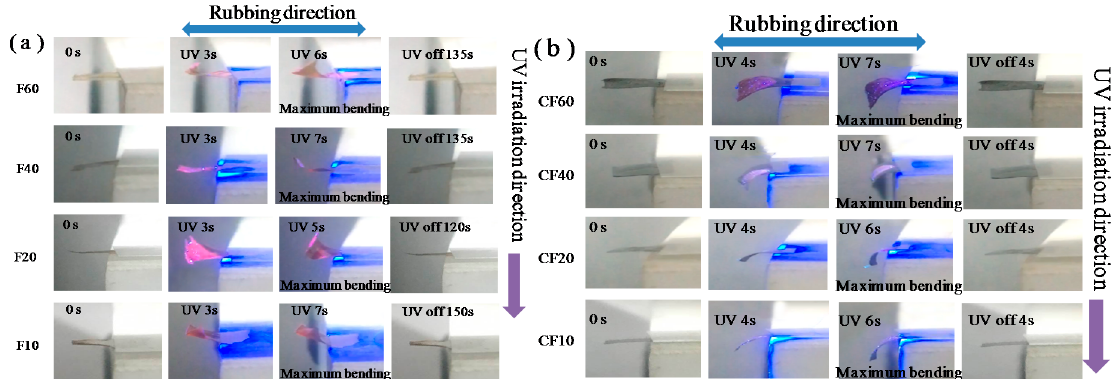
Figure 4. Photographs that exhibit the photoinduced deformation behavior of the AZO-CLCP films ( a ), and the AZO-CLCP/CNT nanocomposite films ( b ). Size of the films: 12 mm × 6 mm × 20 µm. The wavelength and intensity of the used UV light was 366 nm and 1.5 mW/cm 2 respective. The room lamplight kept turning on state